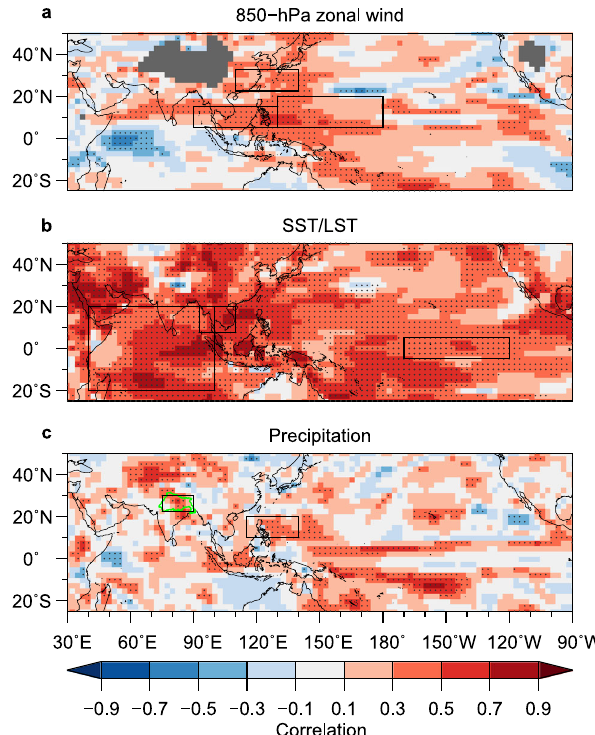
Fig. 2 Prediction skill for the second summer Asian monsoon. Correlation coef fi cients between the observations and ensemble mean predictions for a 850 hPa zonal wind, b sea surface temperature (SST) over the ocean and land surface (2 m air) temperature over land (LST), and c precipitation. Stippled regions are statistically signi fi cant at the 5% level according to Student ’ s t test. Boxes indicate the regions of indices used in this study (Methods). In ( c ), the Ganges basin 53 is shown in